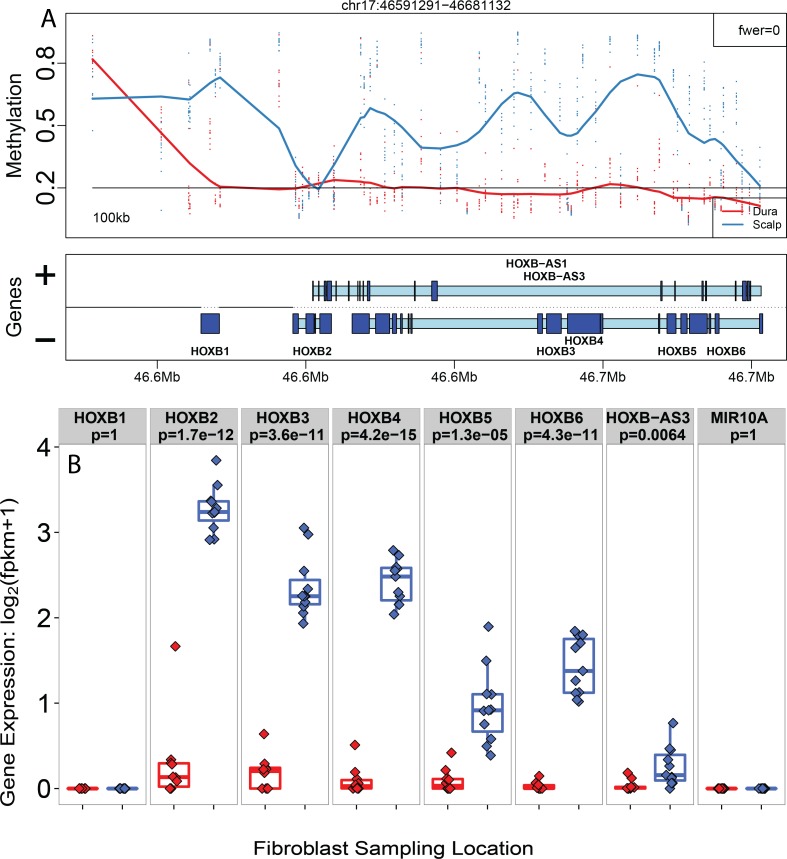
Long-range DNA methylation changes manifest in the transcriptome.(A) Plot of the DNAm levels (proportion methylation) of a significant DNAm block overlapping genes in the HOX family. Y-axis: proportion DNAm levels, x-axis: genomic coordinates on chromosome 17. (B) Corresponding expression levels of the HOX genes within the DNAm block are more highly expressed in the scalp. Y-axis: log2 transformed fragments per kilobase per million mapped (FPKM), x-axis: sampling location.